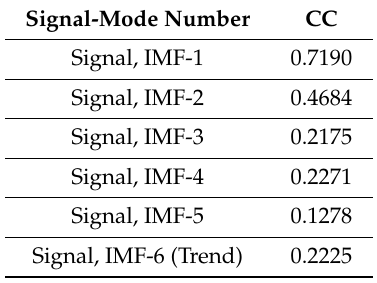
Table 7. Correlation Coefficient (CC) values of the DMI modes and the signal derived from Dataset- 3.